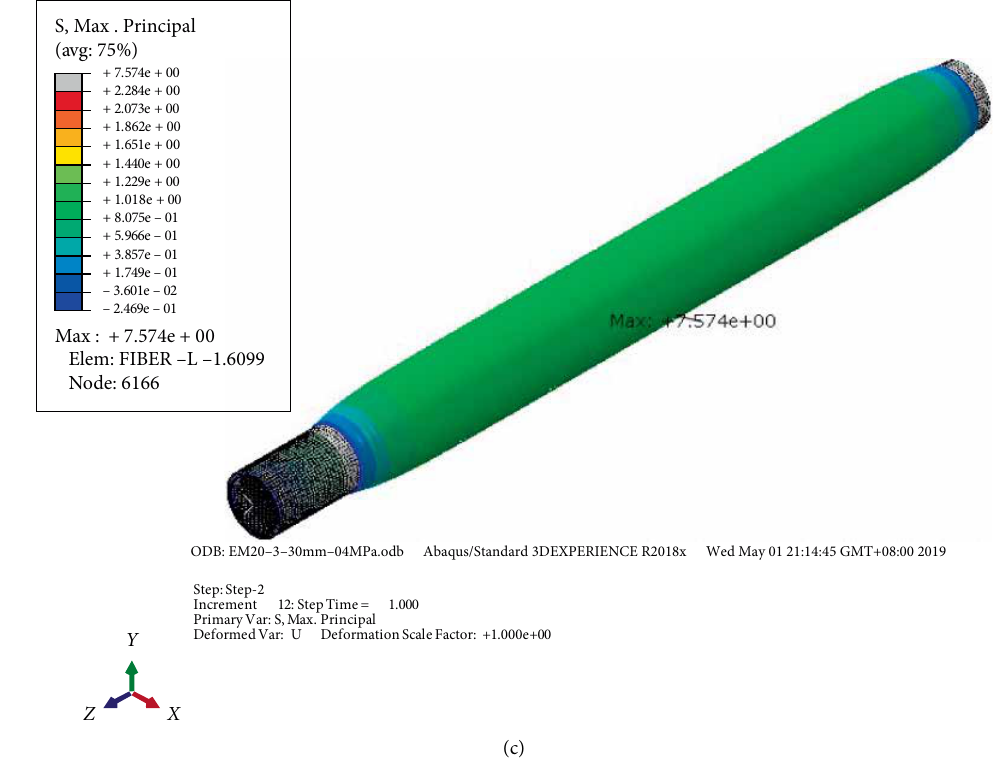
Figure 5: Stress distributions of PAM under the pressures of 0.2 MPa, 0.3 MPa, and 0.4 MPa at the contraction of 10%. (a) 0.2 MPa, (b) 0.3 MPa, (c) 0.4 MPa.